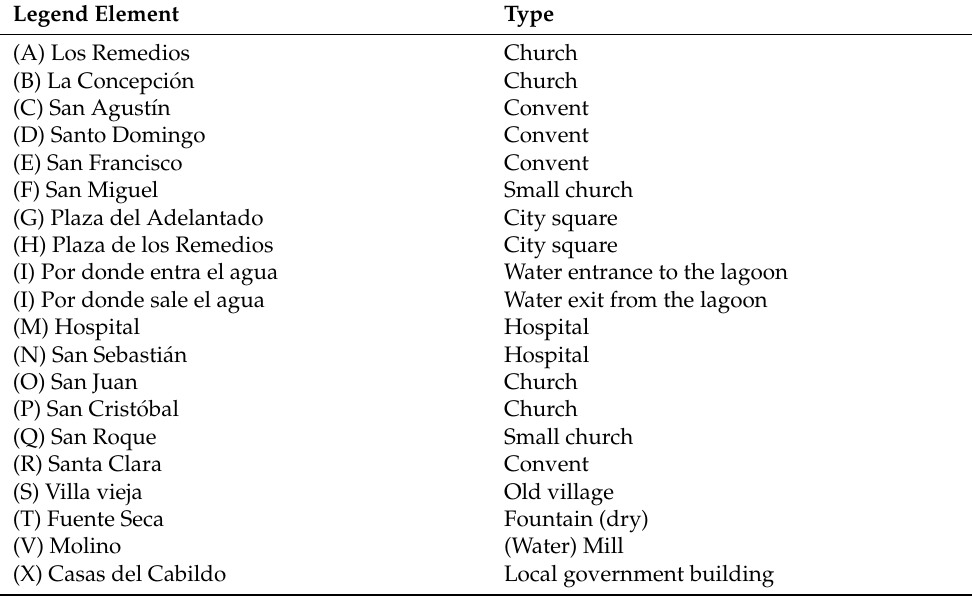
Table 2. Elements in the legend of the